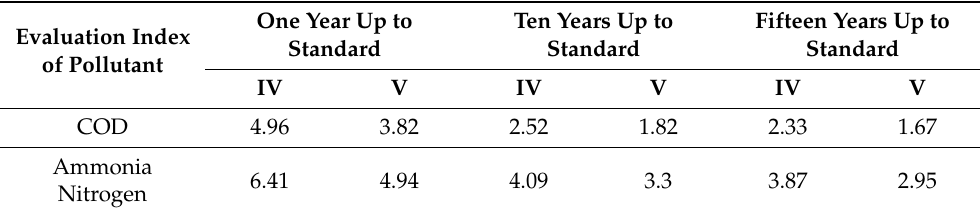
Table 2. The water demand of dilution of COD and ammonia nitrogen meeting to standard in 1, 10 and 15 years (hundred million m 3 ).